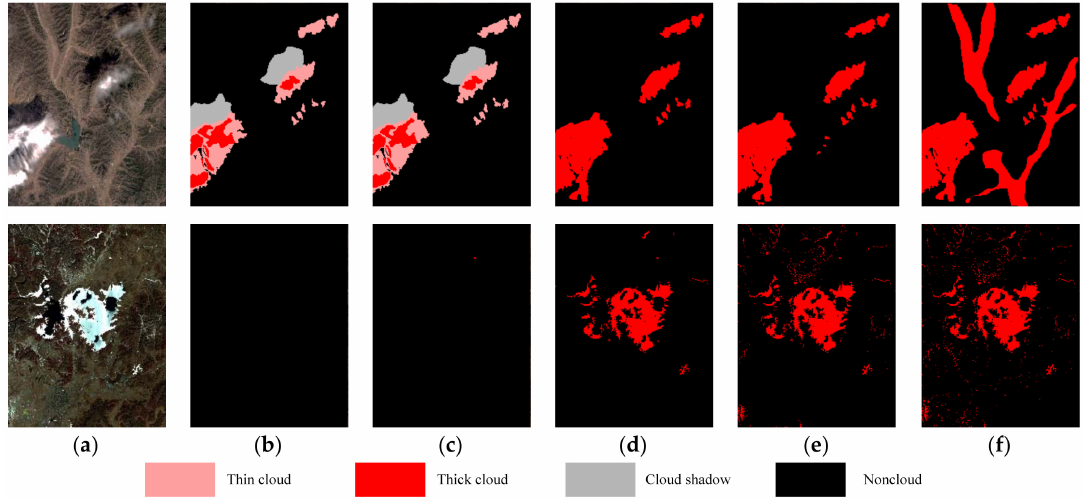
Figure 10. Cloud detection results using different methods. ( a ) Original image; ( b ) ground-truth image; ( c ) our proposed method; ( d ) SVM; ( e ) neural network; ( f )